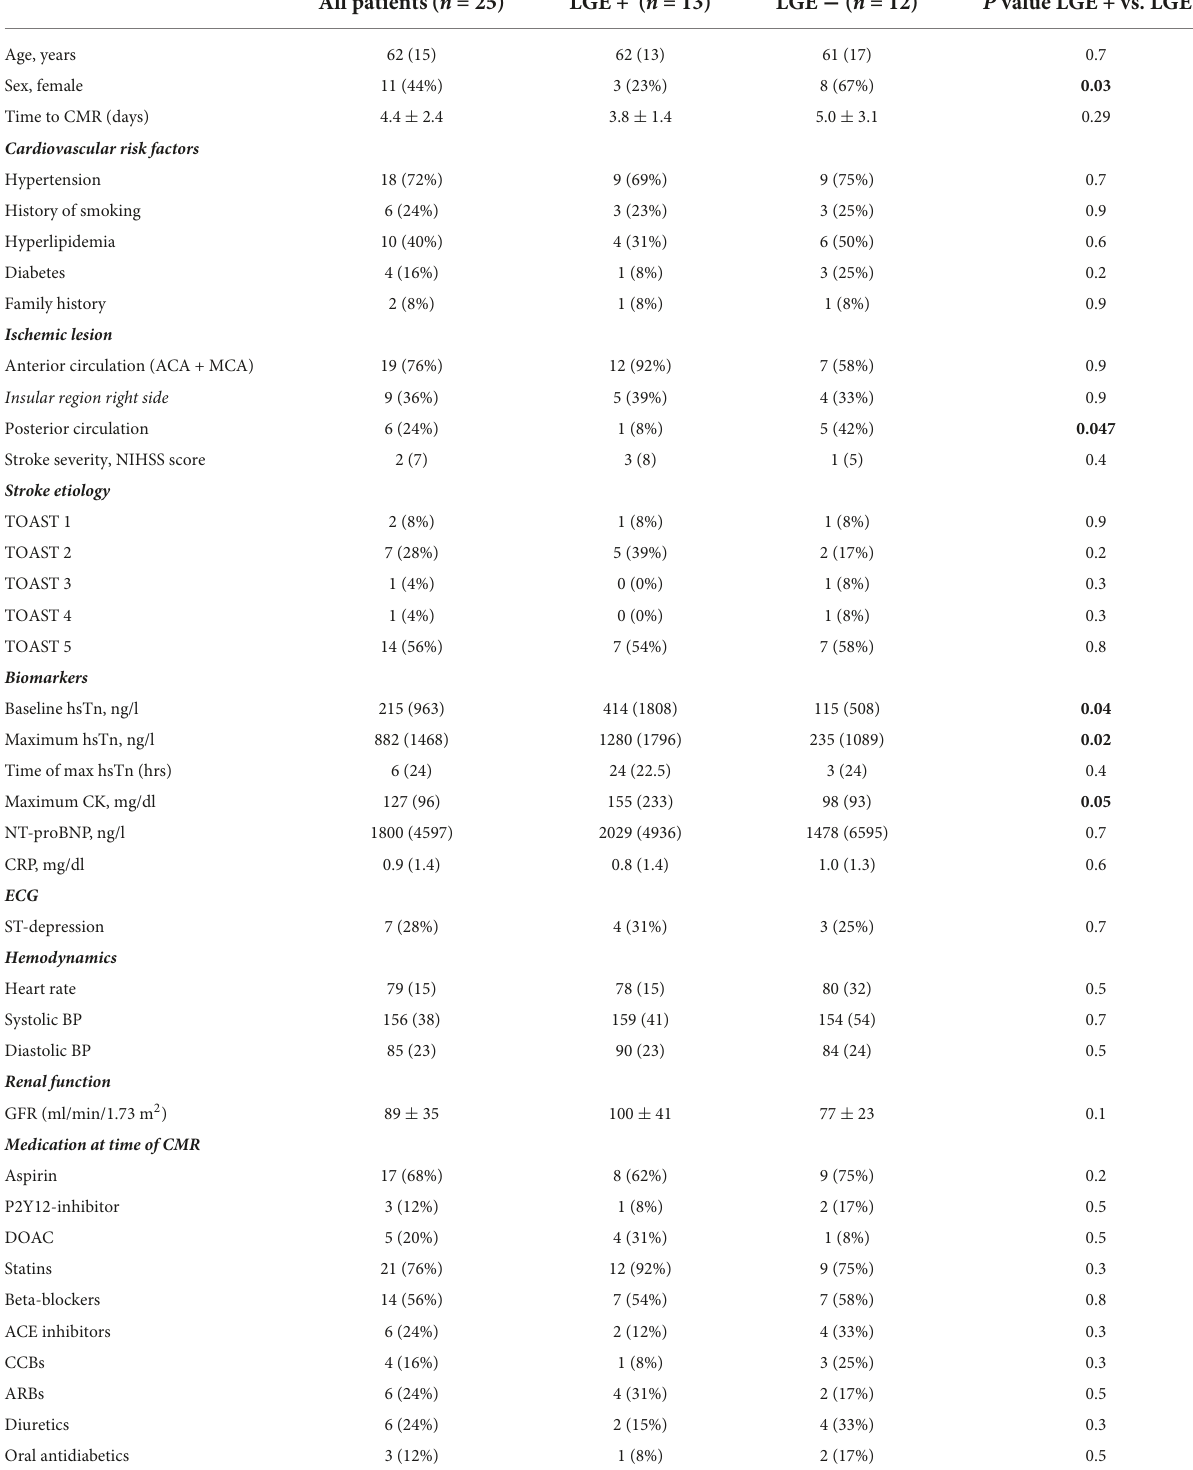
TABLE 1 Patient